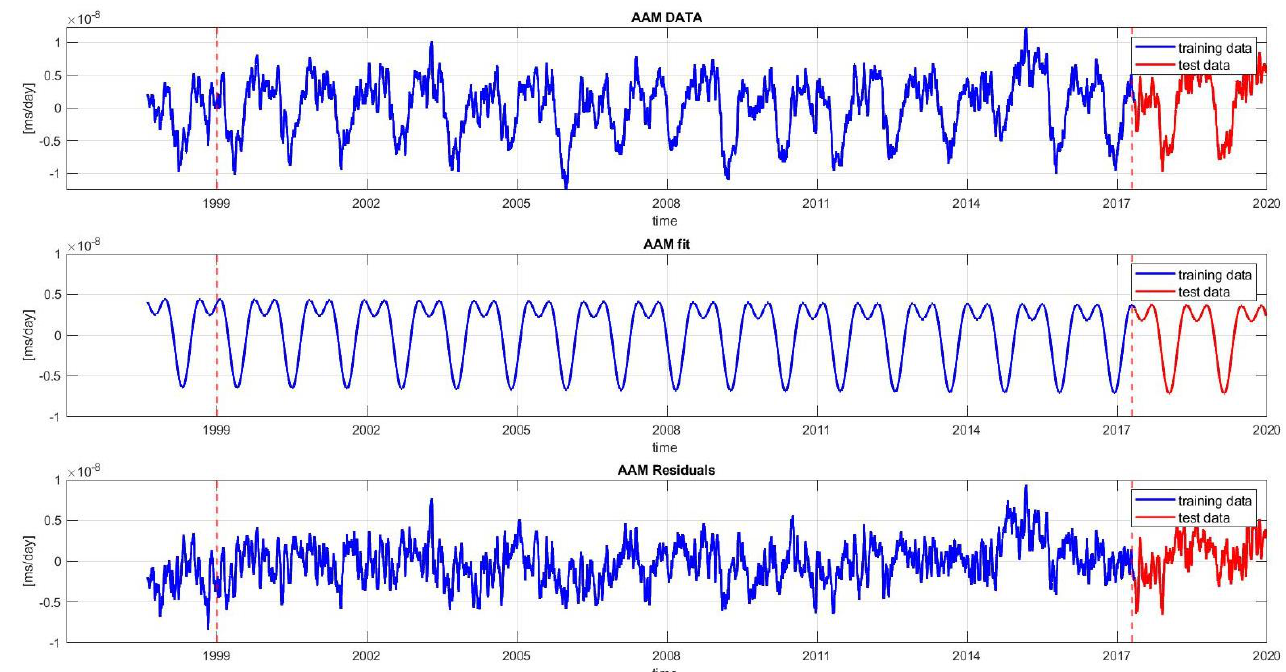
Figure 5. Time series of AAM between 1999 and 2020. From top to bottom, the data series shown are the AAM, trend terms, and AAM Z residual series. The time series is divided into two sets: the training set (1999–2017) and testing set